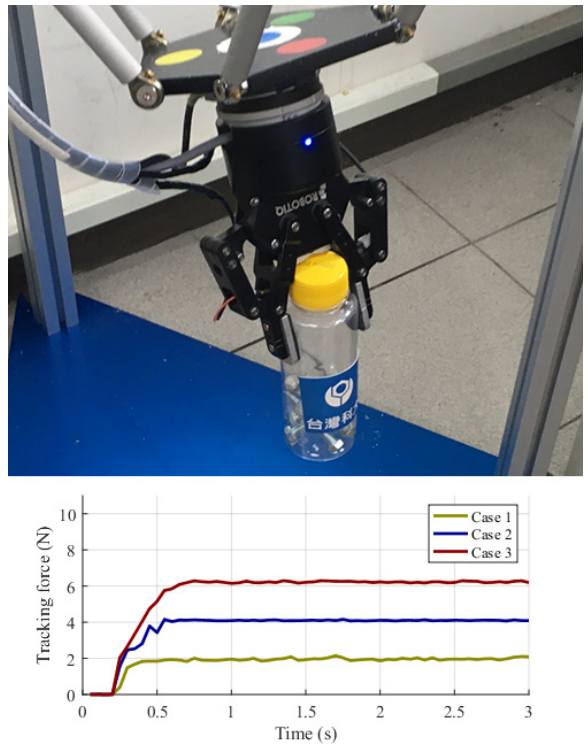
Figure 14. The tracking force of the comparative Experiment 2.